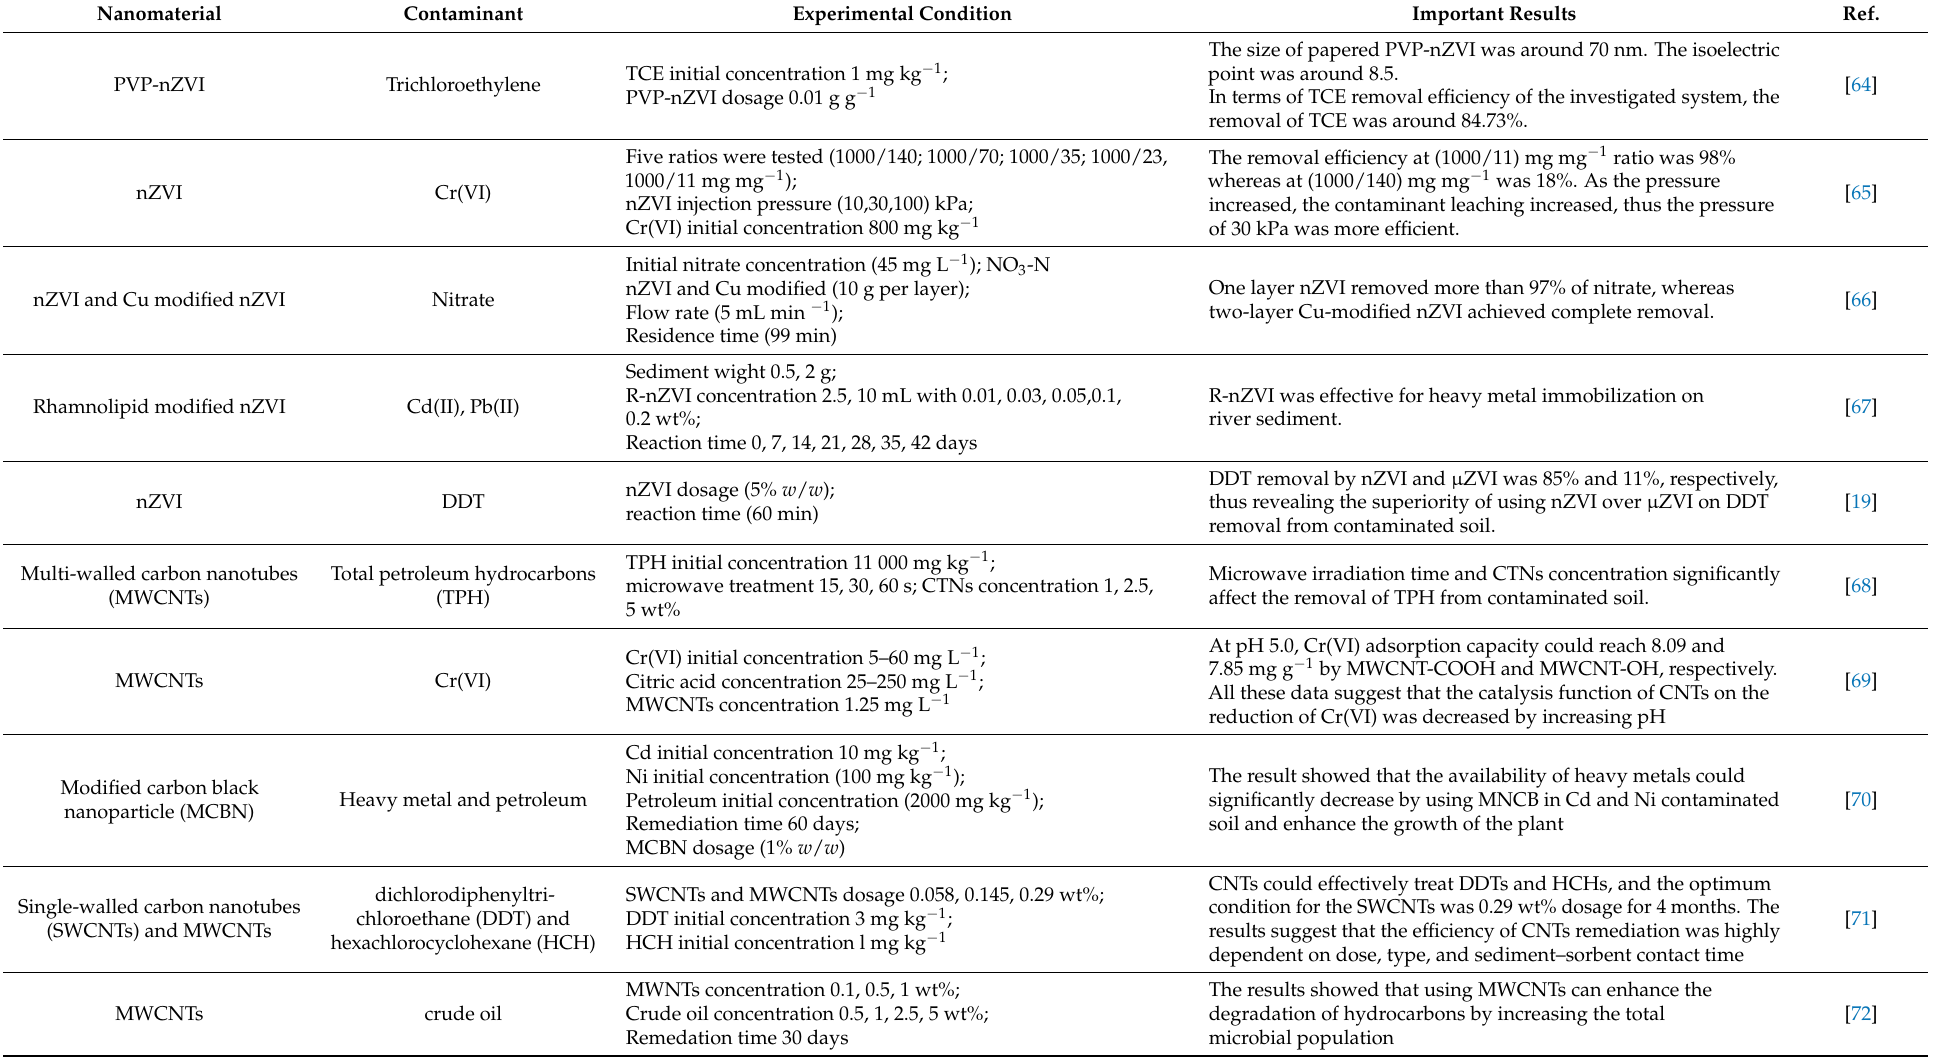
Table 1. Recent studies that employed nanoremediation methods for soil